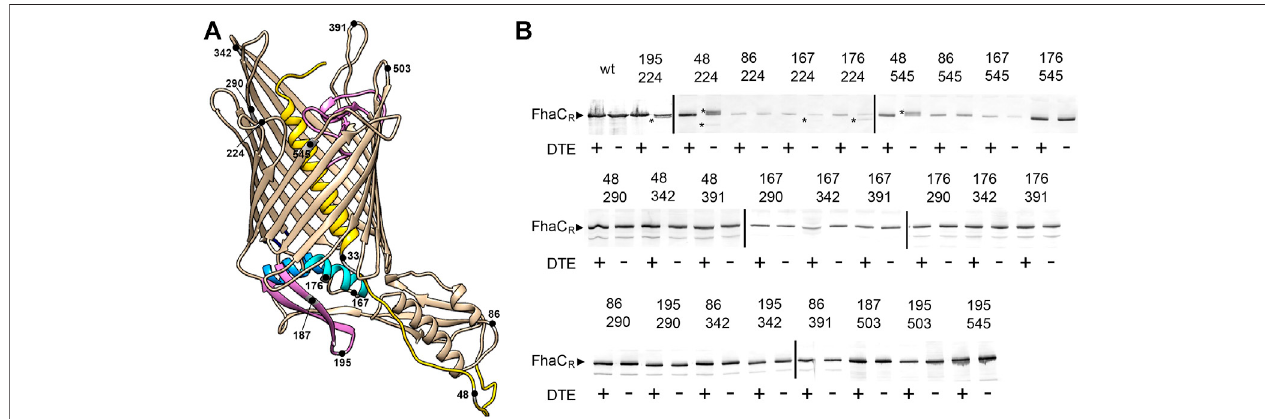
FIGURE 2 | Detection of transient conformers of FhaC in vivo . (A) Structural model of FhaC (PDB 4QKY) and positions of the Cys substitutions. Helix H1 and loop L6 are drawn in yellow and purple, respectively; POTRA2 helix H4 and hairpin b5-b6 are in cyan and purple. (B) Immunoblot of membrane fractions of E. coli JCB571 ( dsbA KO strain) producing FhaC variants. The numbers indicate the positions of the two Cys residues. The reducing agent DTE was added to one half of each sample. FhaC R represents the position of the reduced form. The asterisks point to the additional, intramolecular cross-linked forms that can migrate faster or more slowly than the reduced form, depending on the respective positions of the two Cys residues. At least three independent replicate experiments (cultures and blots) were performed for all variants. Note that the fuzzy band for FhaC(Cys167 + Cys342) in the +DTE lane, which was not reproducibly observed, does not correspond to a S-S-bonded species, since it was found only in the presence of the reducing